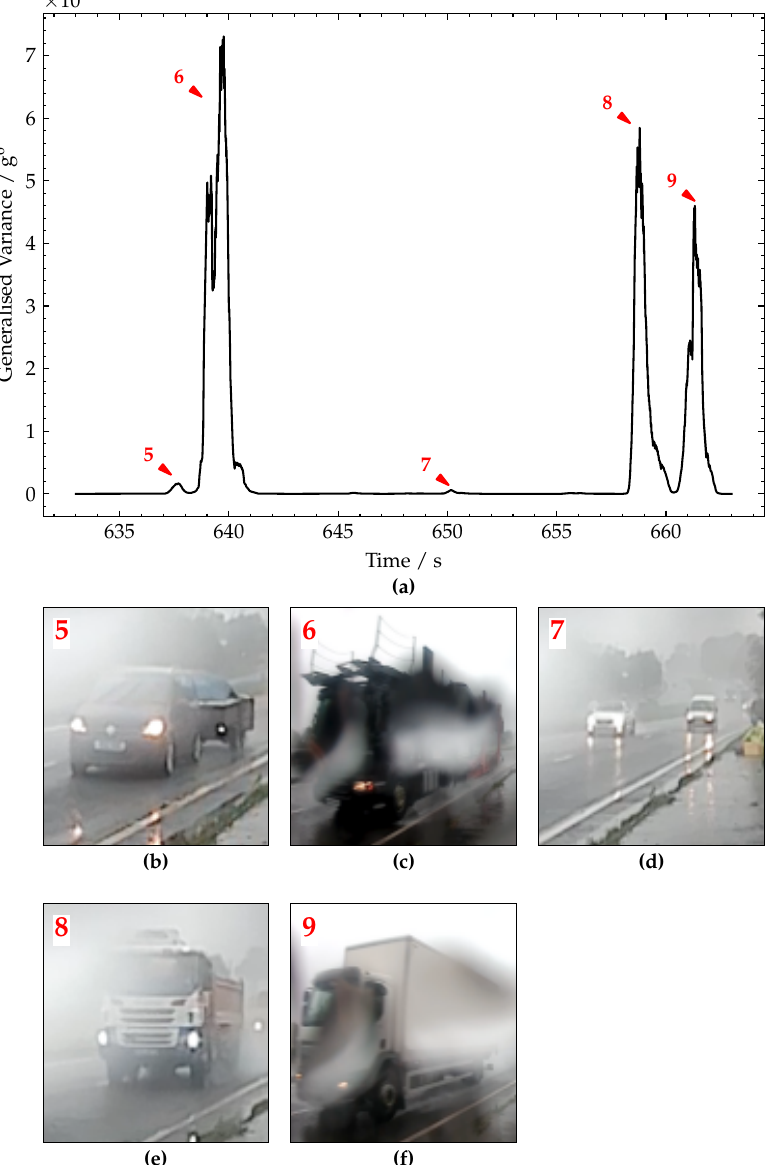
Figure 16. ( a ) Plot of generalised variance signal. ( b – f ) Pictures of vehicles corresponding to peaks annotated 5–9,